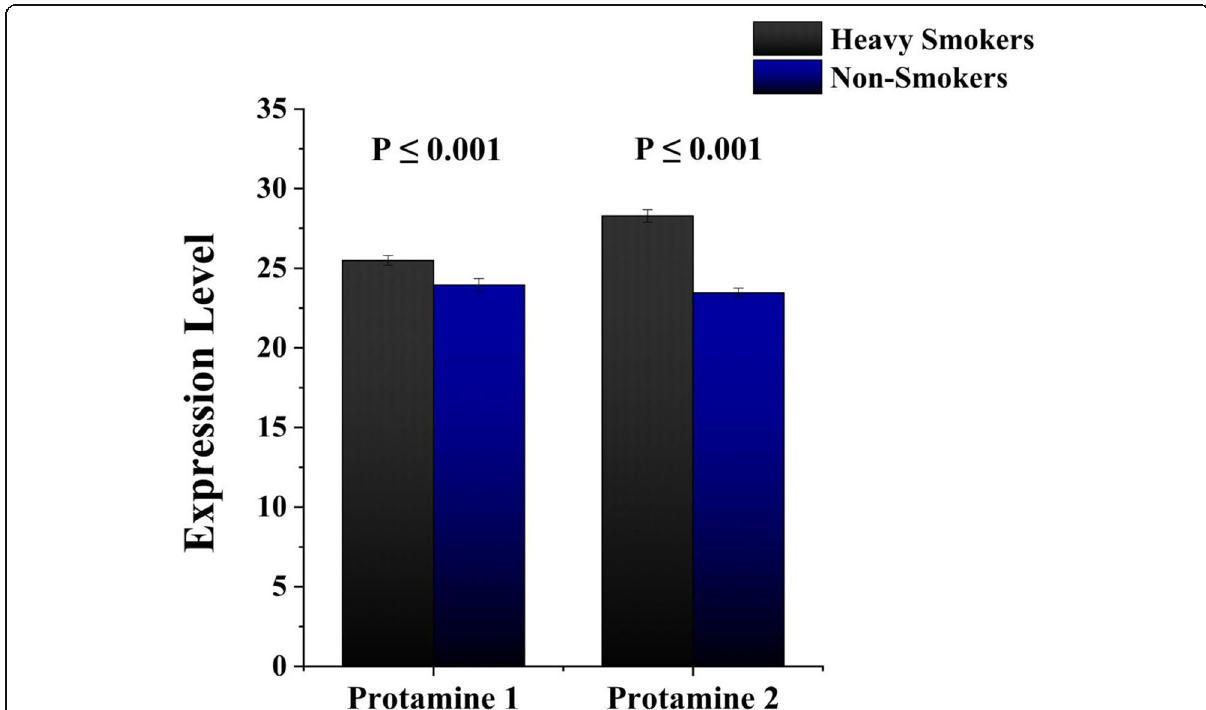
Fig. 2 Transcription level of protamine genes (1 and 2) in heavy smokers compared to non-smokers. P > 0.05: not significant; P < 0.05: significant. C t levels are inversely proportional to the amount of target RNA in the sample